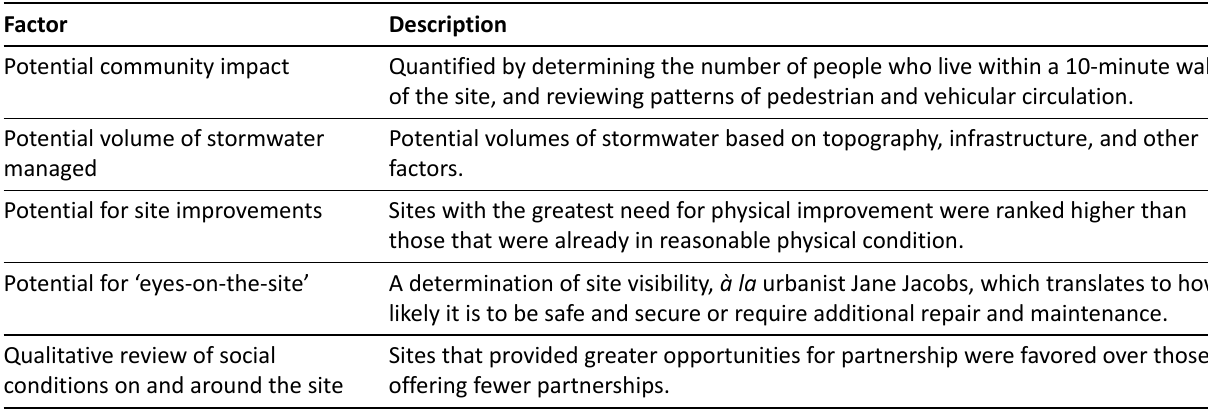
Table 2. A description of the qualitative factors assessed and compared during multifunctional GI site prioritization. Factor Description Potential community